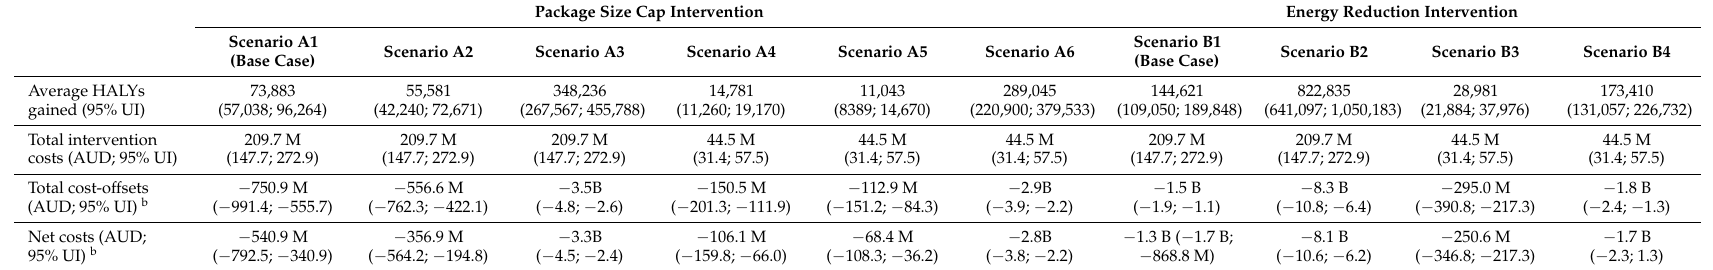
Table 5. Cost-effectiveness analyses for the package size cap and energy reduction interventions a